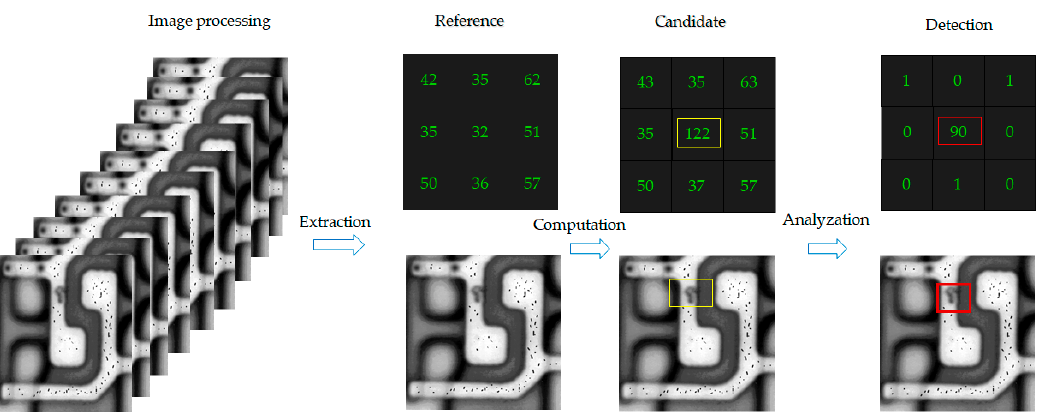
Figure 1. The acquired image is extracted, computed, and analyzed by automatic data acquisition program (ADAP).